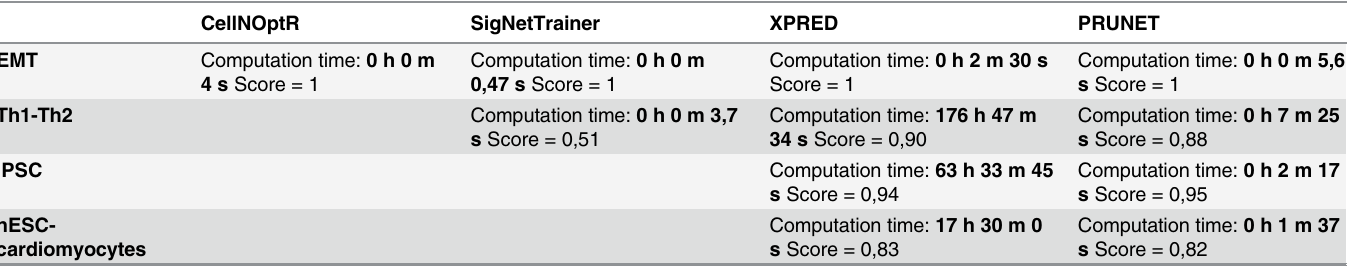
Table 2. Comparison of PRUNET with similar available